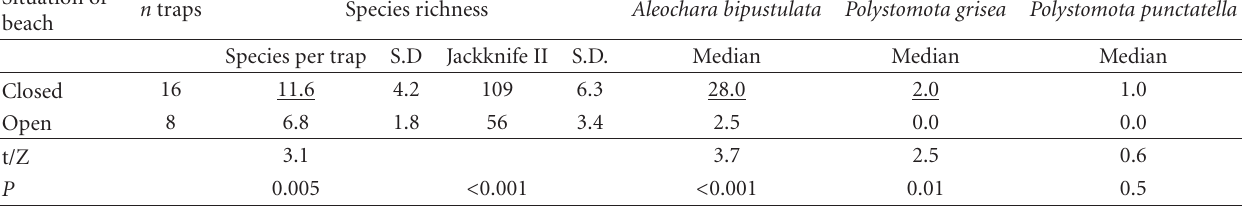
Table 5: Species richness and median abundance of three species in four sandy beaches closed to tourists and two beaches open to tourists with results of t -test or U test; significant di ff erences are